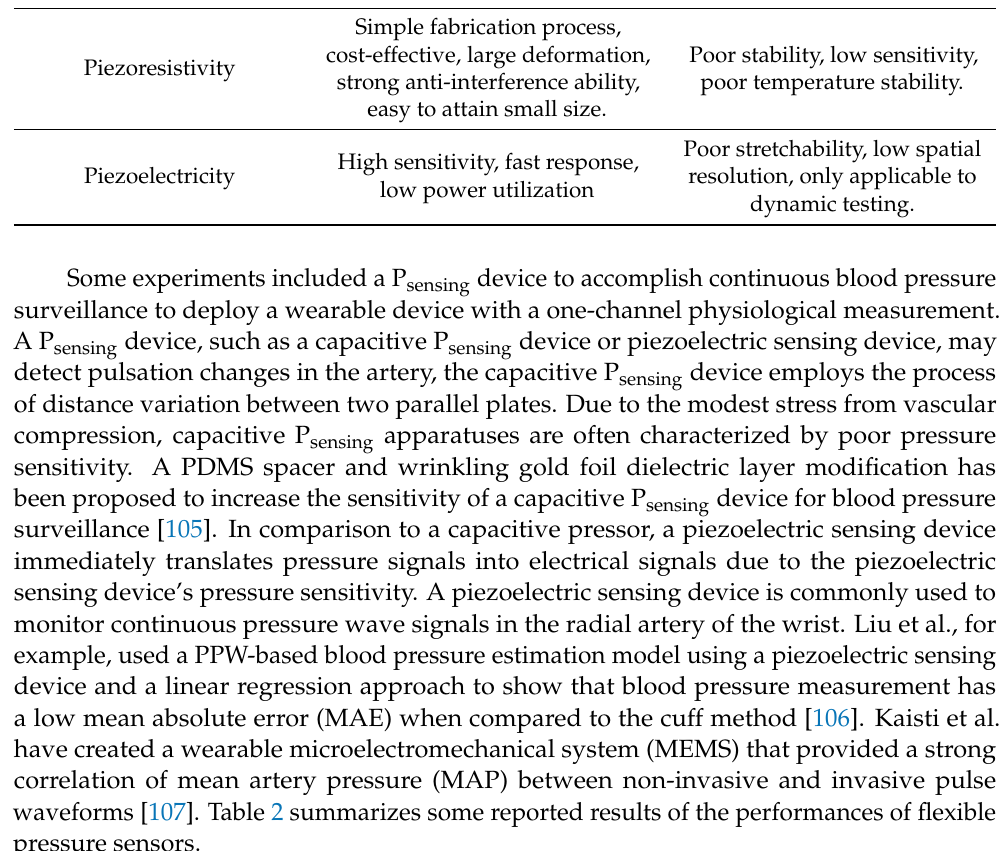
Table 1. Pros and cons of the three types of P sensing apparatuses. Inspired by the work in [99]. Transduction Principles Pros Cons Extraordinary sensitivity, simple Poor linearity, vulnerable to structure, big dynamic span, good EM interference, prone to Capacitance temperature constancy, fast parasitic capacitance. response, appropriate for small force test. Simple fabrication process, Poor stability, low sensitivity, cost-effective, large deformation, Piezoresistivity poor temperature stability. strong anti-interference ability, easy to attain small size. Poor stretchability, low spatial High sensitivity, fast response, Piezoelectricity resolution, only applicable to low power utilization dynamic testing.